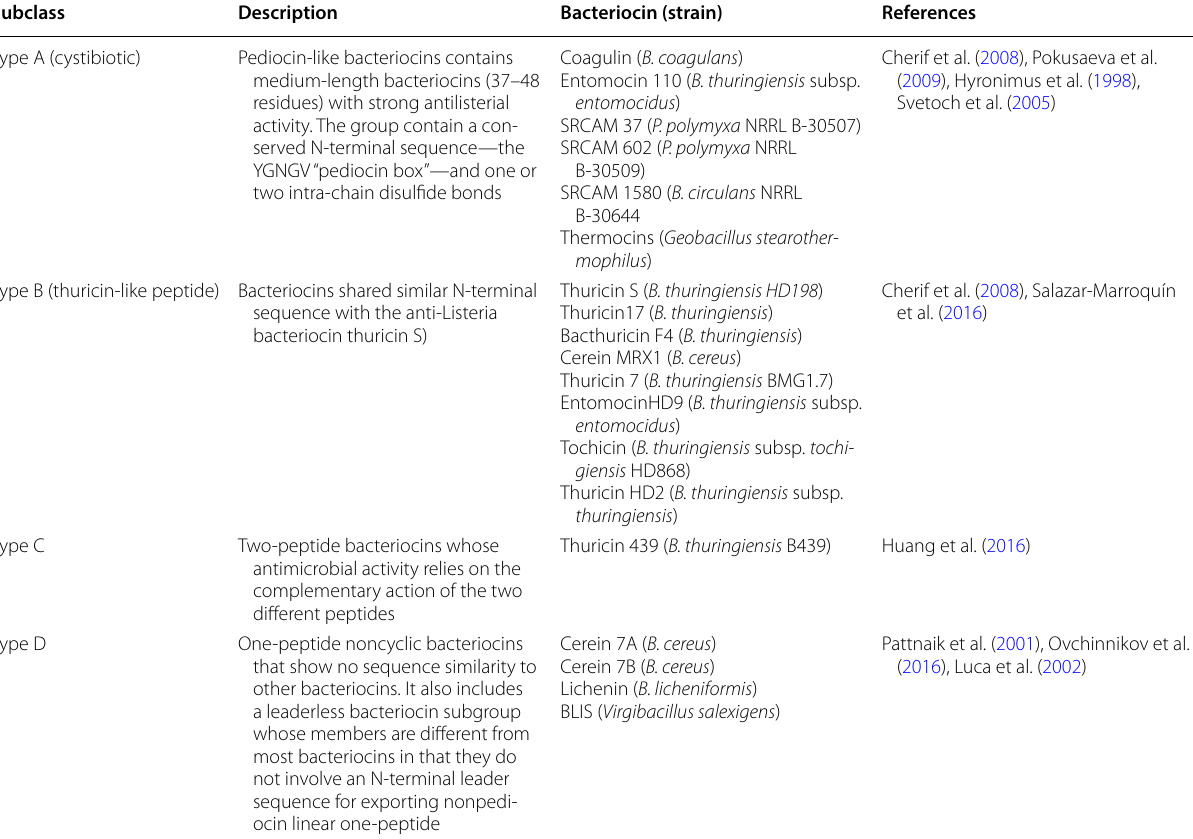
Table 2 Proposed classification of Bacillaceae bacteriocins in class II (post-translationally unmodified peptides)